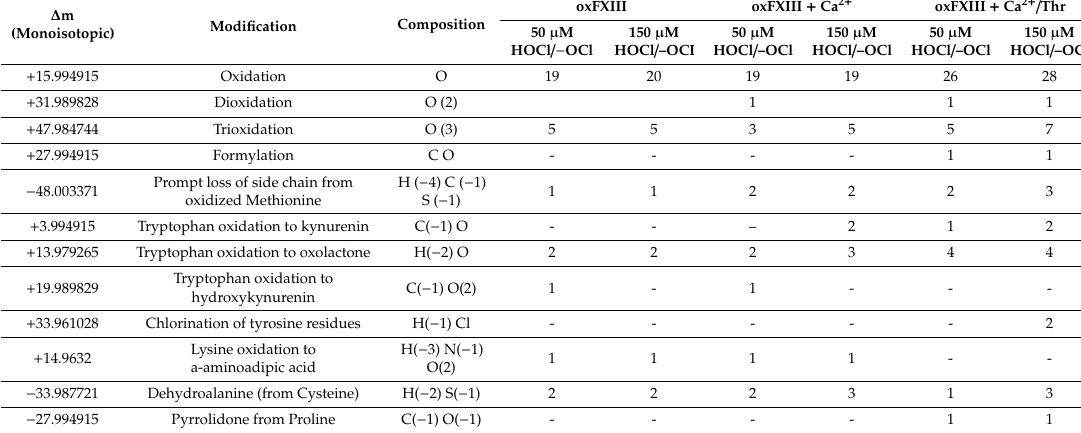
Table 1. Detected oxidative modifications and their numbers for the samples of FXIII oxidized by 50 and 150 µ M HOCl / –OCI in the FXIII